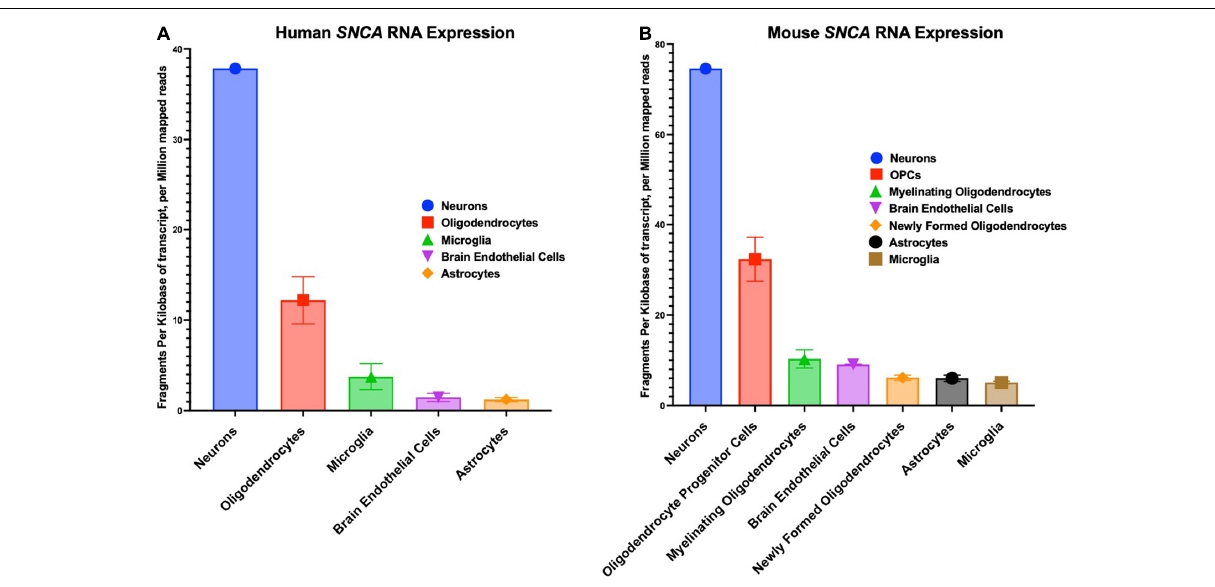
FIGURE 2 | Cellular distribution in the central nervous system of SNCA RNA expression. (A) Human cellular distribution of SNCA transcripts. (B) Mus musculus cellular distribution of SNCA transcripts. RNA-Seq data used for these graphs were obtained and adapted from the Ben Barres lab’s brain RNA-seq